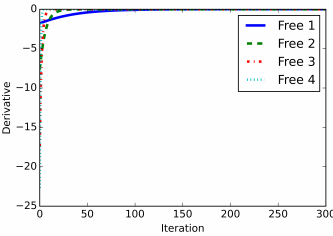
( k ) ) with respect to a c